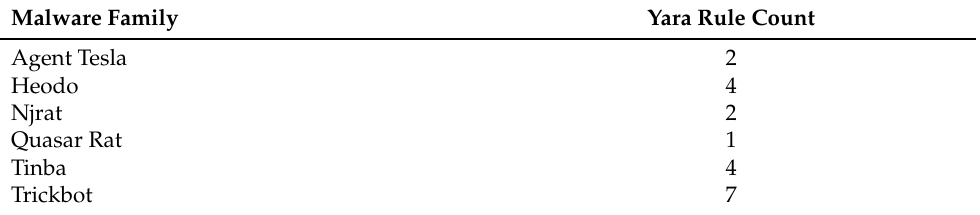
Experiment 6: Comparison Against Yara Rules. The Yara rules from Malpedia